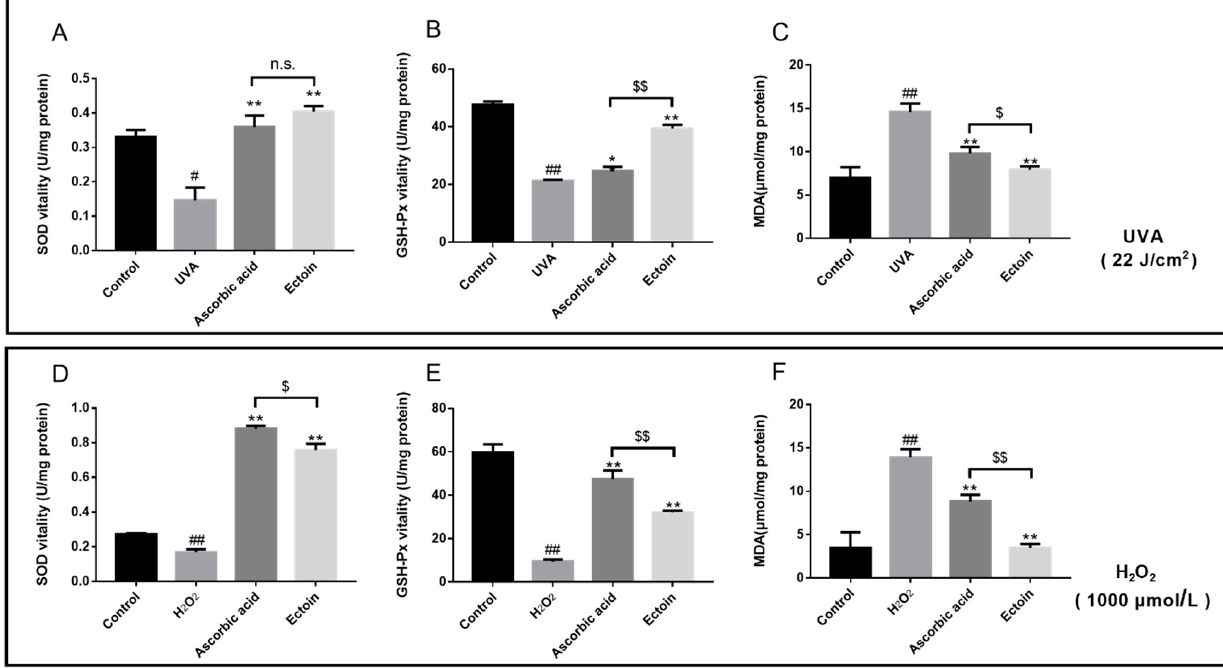
Figure 3. The antioxidant activities of Ectoin on the total SOD activities ( A , D ), GSH-Px activities ( B , E ), MDA contents ( C , F ). The uppercase ( A – C ) represents the UVA-induced damaged study, while the lowercase ( D – F ) represents the H 2 O 2 -induced damaged study. Ascorbic acid (60 µ g/mL, 24 h) was chosen as the positive control. The model in ( A – C ) was established by UVA (22 J/cm 2 ), and the model in ( D – F ) was established by H 2 O 2 (1000 µ mol · L − 1 ). Statistical significance was de- termined by ANOVA test. (## p < 0.01, and # p < 0.05, compared with the Control. * p < 0.05, and **